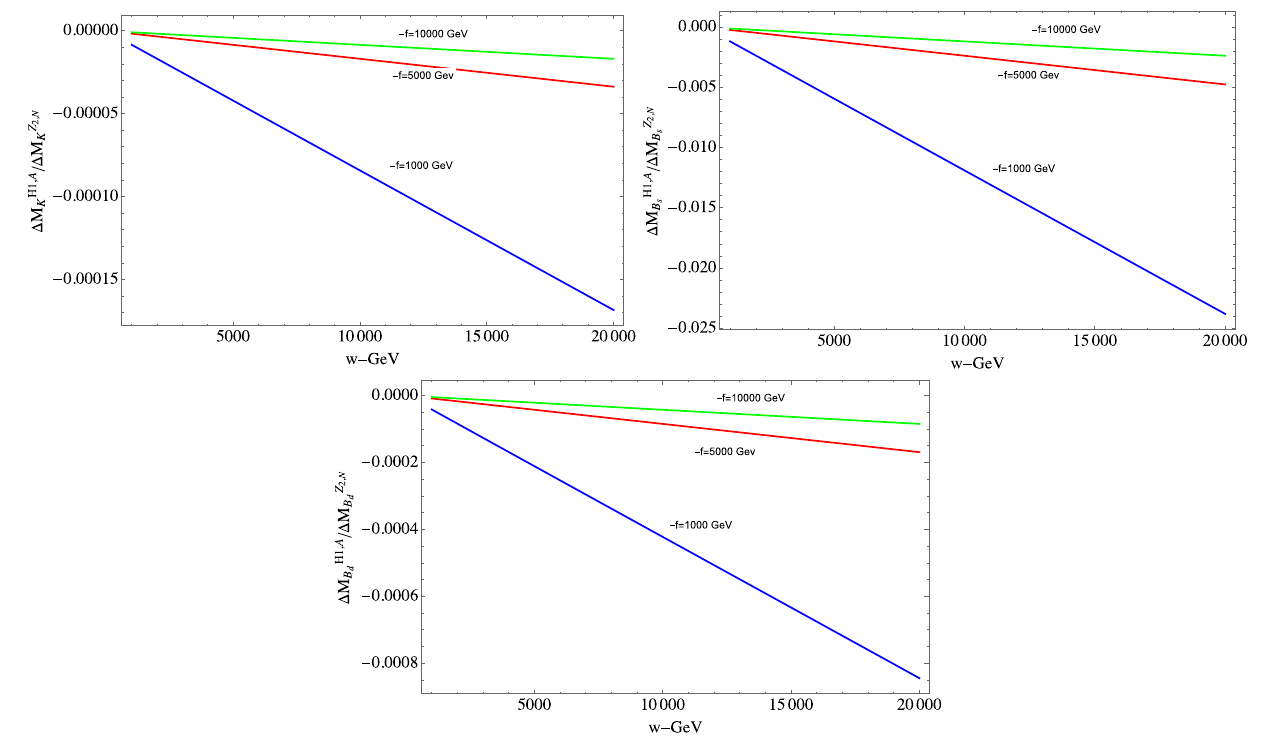
Fig. 2 The figures present the dependence of ratios (cid:3) m H 1 , A